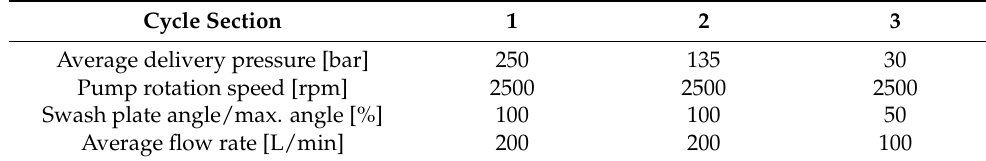
Table 1. Pump working conditions in first simulation cycle.